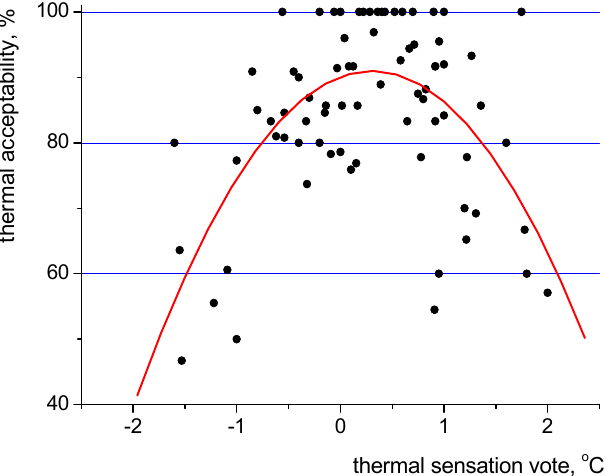
Figure 14. Relationship between average thermal acceptability and average thermal sensation vote based on 1369 questionnaires.